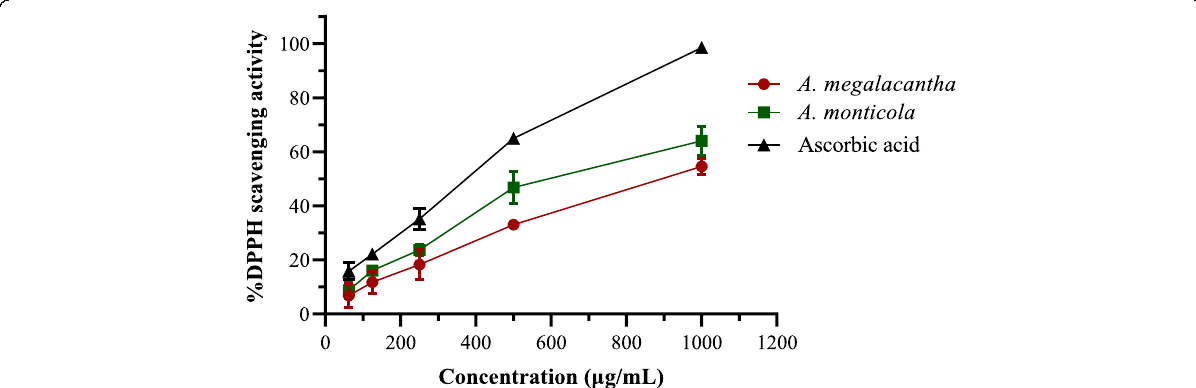
Fig. 4 DPPH radical hunting property of the leaves latexes of A. megalacantha and A. monticola in comparison with the effect of ascorbic